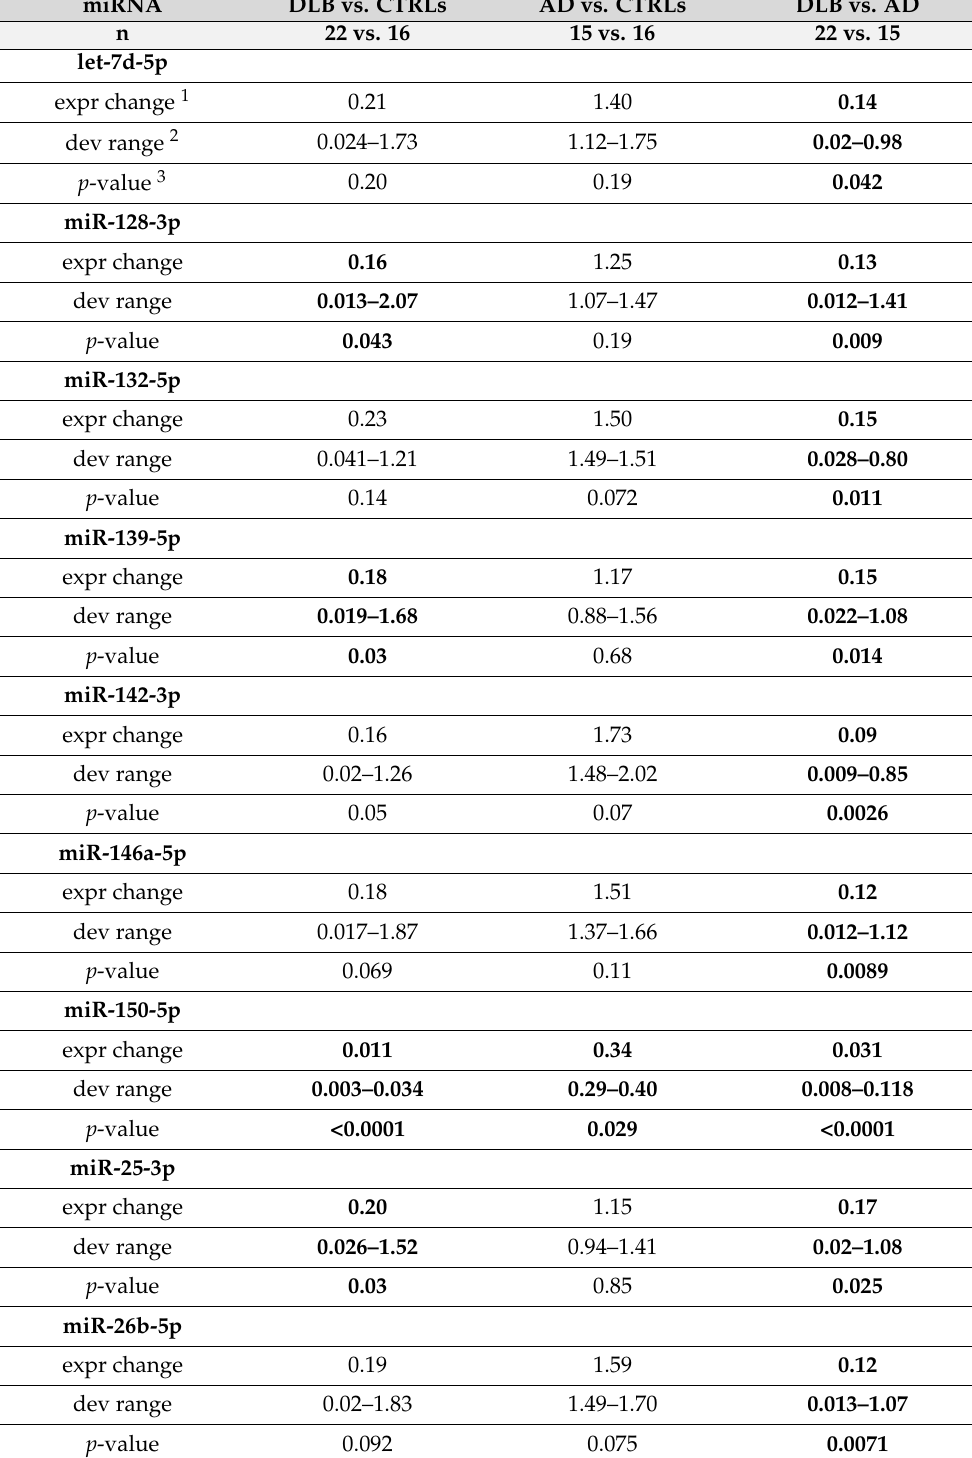
Table 3. MiRNA expression results: Study